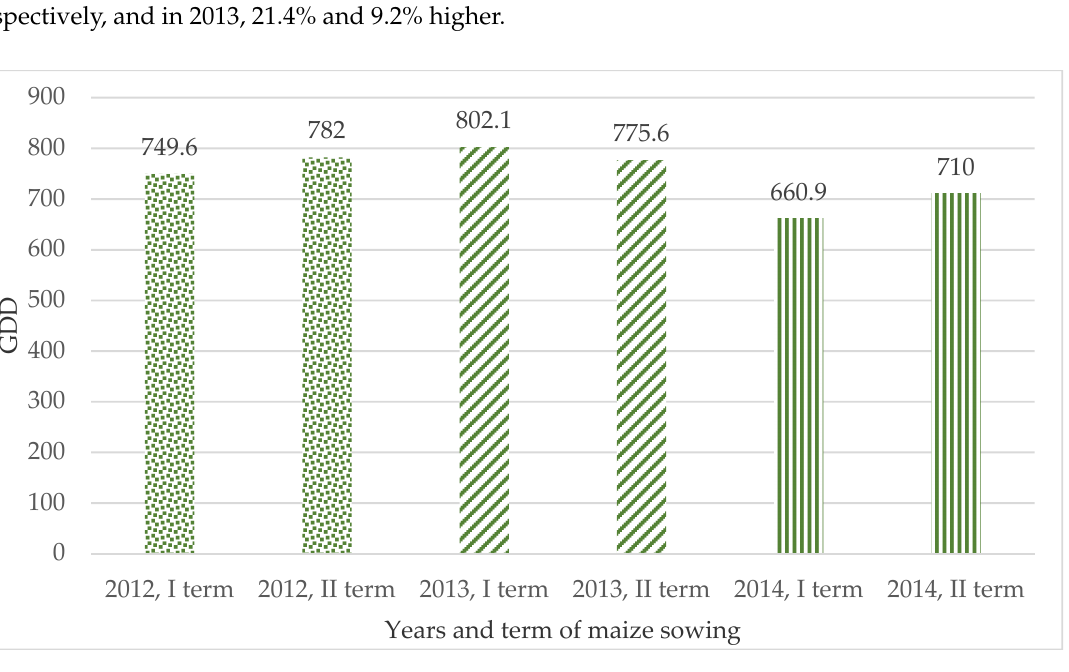
Figure 2. Growing degree days during the sweet maize vegetation period.